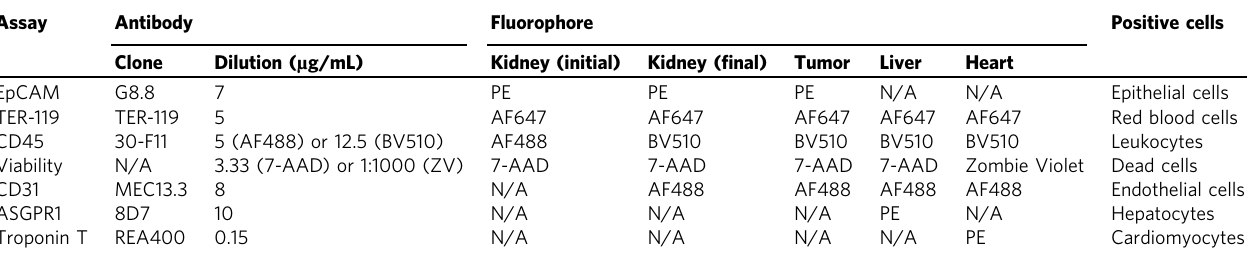
Table 1 Flow cytometry probe panels.